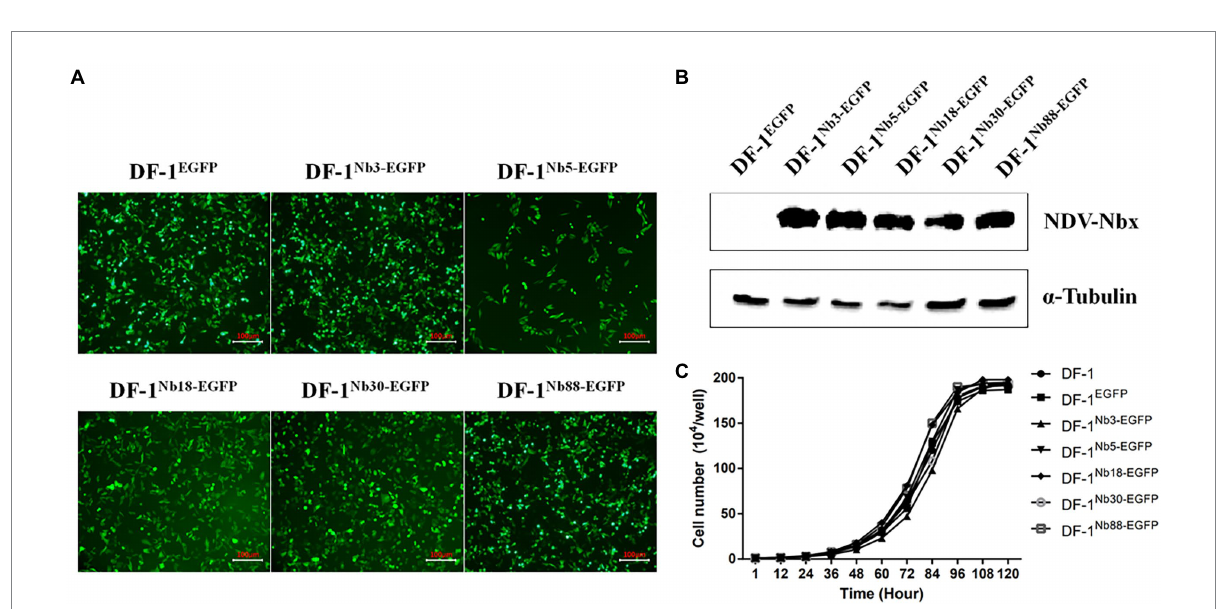
FIGURE 4 Establishment of recombinant DF1 cell lines stably intracellularly expressing enhanced green fluorescent protein (EGFP), Nb3-EGFP, Nb5-EGFP, Nb18-EGFP, Nb30-EGFP, and Nb88-EGFP. (A) All six recombinant DF1 cells lines stably expressing EGFP proteins were observed under a fluorescence microscope. (B) Detection of nanobodies with HA and EGFP tags in the recombinant DF1 cell lines via Western blotting analysis using anti-HA mAbs as primary antibodies. (C) Analysis of cell growth curves of the six recombinant DF1 cell lines. These were determined for cells seeded in 96-well plates (5 × 10 4 cells/well). Assays were performed in triplicate, and data are expressed as the mean ± SD.